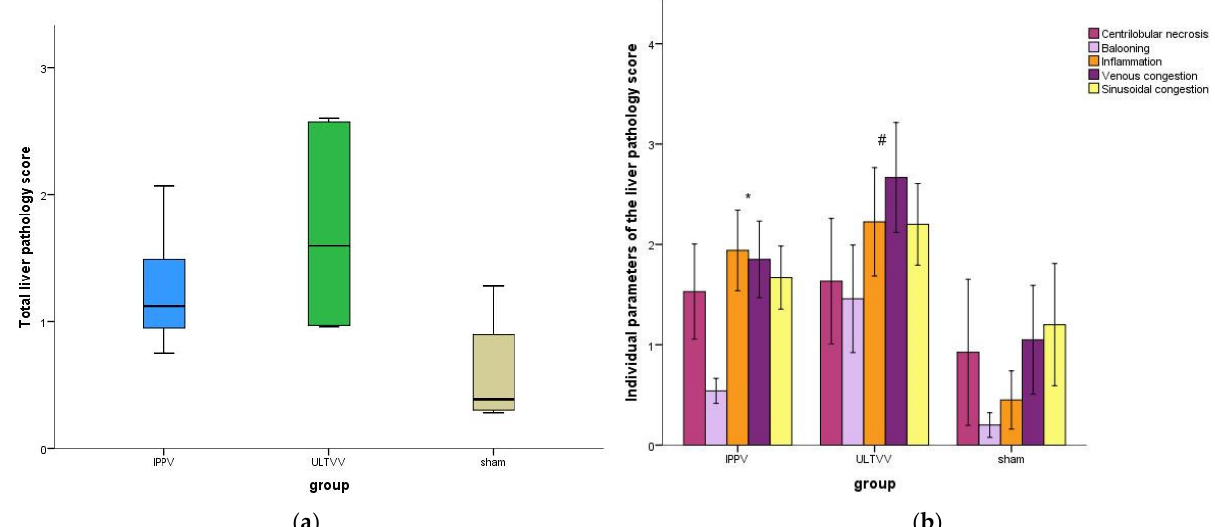
Figure 5. Histopathological scoring of the liver. ( a ) Total liver pathology score. ( b ) Individual parameters of the liver pathology score. Mean (±1 SE). * indicates p < 0.05 for IPPV vs. sham # indicates p < 0.05 for ULTVV vs. Sham. IPPV: Intermient positive pressure ventilation. ULTVV: Ultra-low tidal volume ventilation.